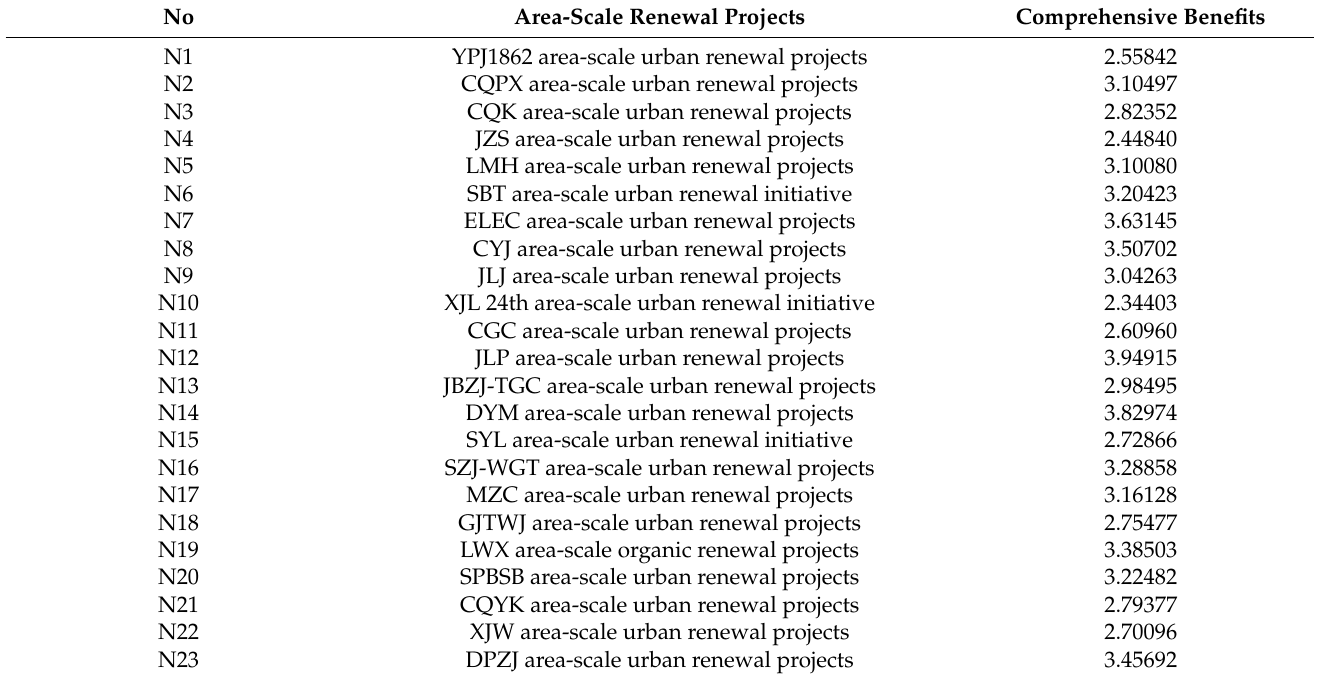
Table 3. The initial evaluation value of comprehensive benefit for 37 area-scale renewal